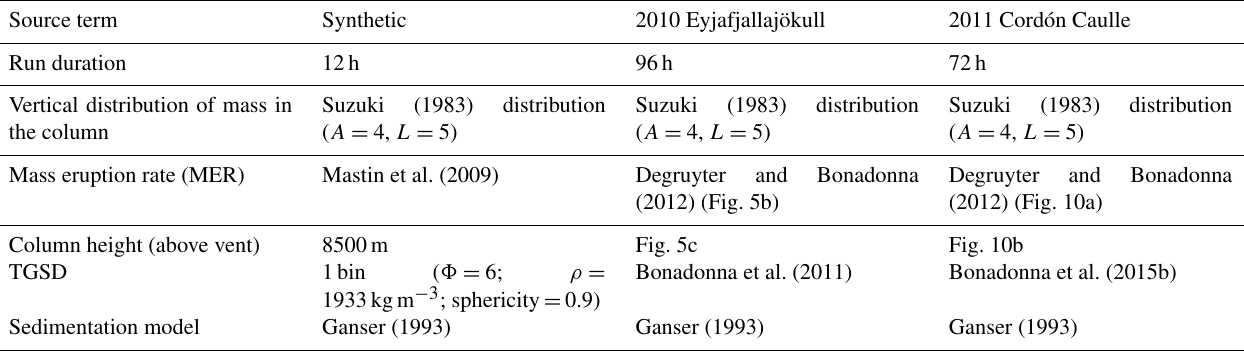
Table 2. Summary of eruption source parameters (ESPs) used in NMMB-MONARCH-ASH for the synthetic case and the 2010 Eyjafjalla- jökull and 2011 Cordón Caulle applications.